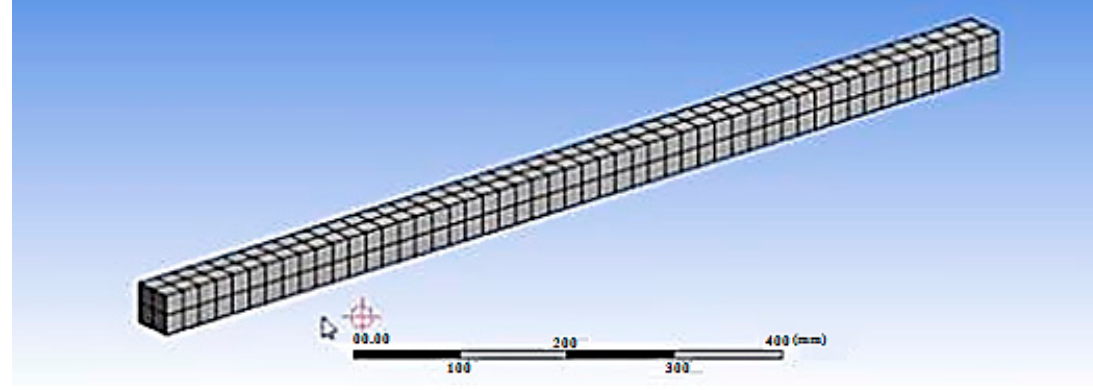
Figure 12. The meshed model.